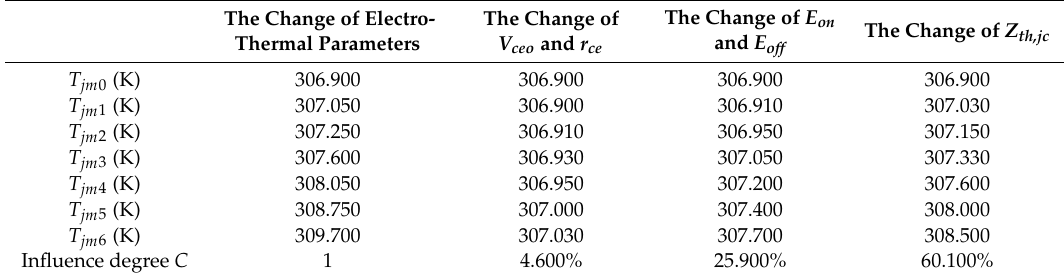
Table 6. The degree of influence of electro-thermal parameters on junction temperature.